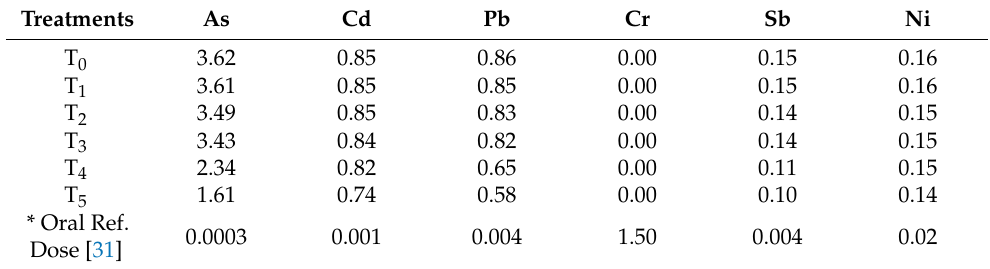
Table 4. Health risk index (HRI) of rice consumption due to heavy metals intake. Treatments